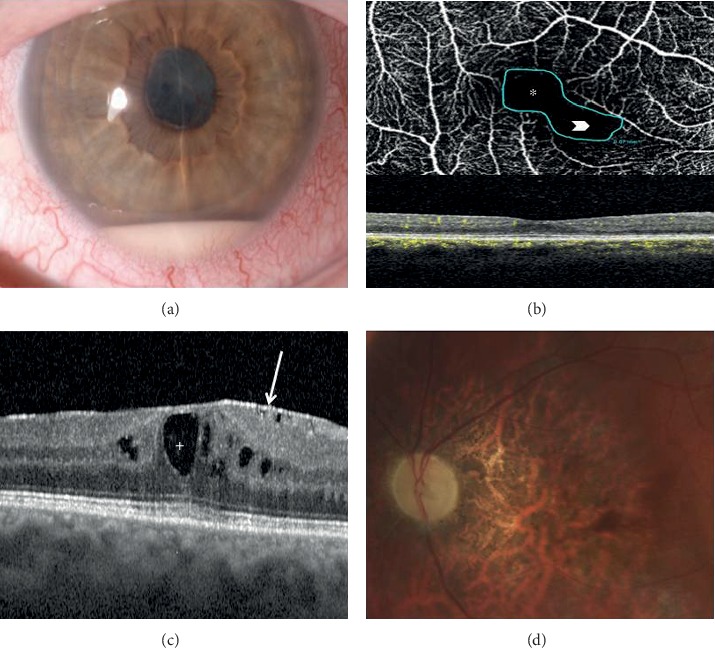
Sight-threatening complications of Behçet's syndrome- (BS-) related uveitis encountered in our cohort: (a) anterior chamber hypopyon in a case of BS-related panuveitis complicated with synechiae and cataract (right eye); (b) BS-related posterior uveitis complicated by macular epiretinal membrane (arrow) and chronic cystoid macular edema (plus) (right eye); (c) OCT angiography showing pathological enlargement of the foveal avascular zone (FAZ) (asterisk) along with a contiguous area of capillary dropout in the superficial retinal capillary plexus (arrowhead) as a sign of retinal ischemia (right eye); (d) optic nerve and macular atrophy due to the severe posterior pole vasculitis of the RE of a patient affected by refractory BS posterior uveitis.